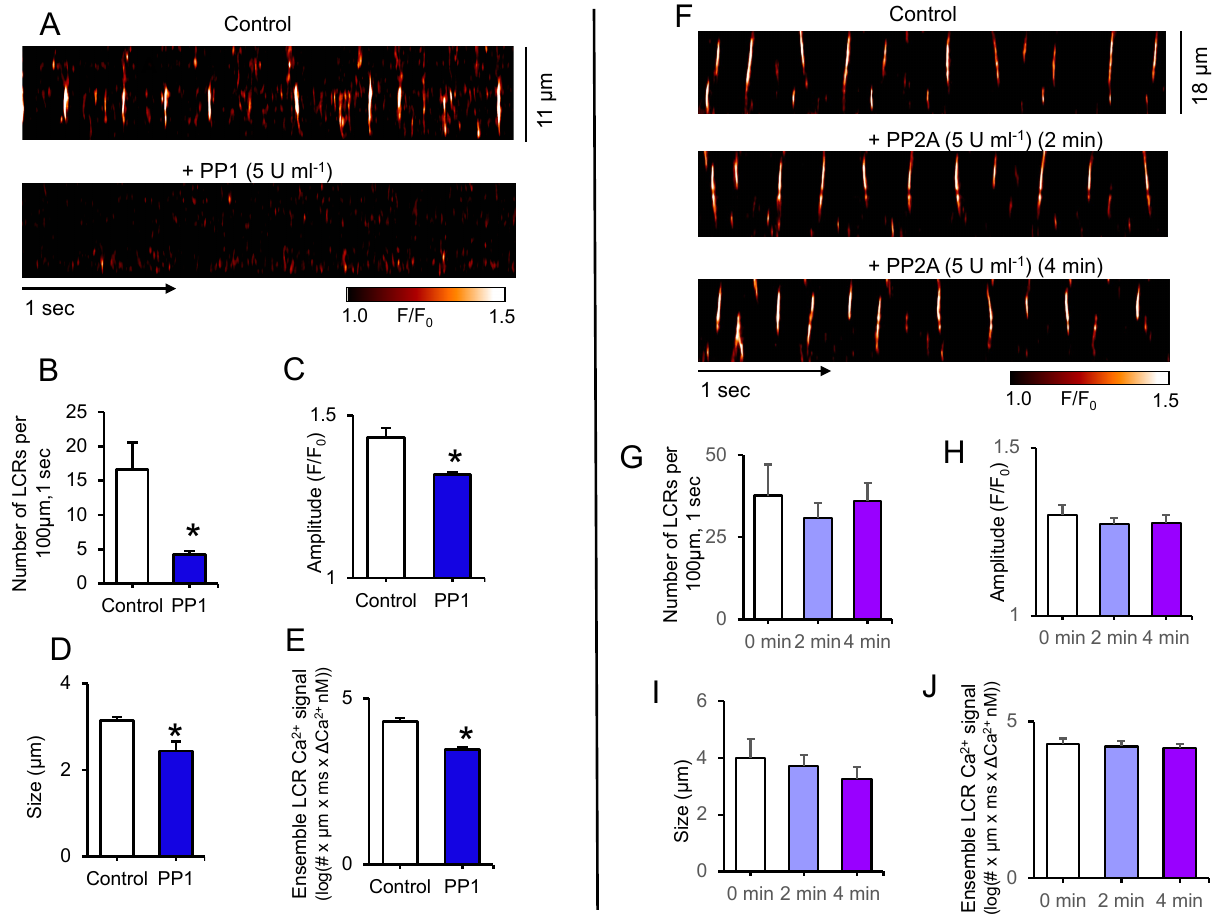
Figure 5. Representative confocal line-scan images of LCRs in permeabilized SANC bathed in 150 nmol/L [Ca 2+ ] in control conditions and during incubation with purified PP1 (5 U mL − 1 ) ( A ) or PP2A (5 U mL − 1 ) catalytic subunits ( F ). Changes in local Ca 2+ release (LCRs) characteristics before and during exposure to PP1 ( n = 4) ( B – E ) or PP2A ( n = 6) ( G – J ); ( B , G ) Number of LCR events per 100 µ m of the line-scan image and during a 1-sec time interval; ( C , H ) LCR amplitude (F/F 0 ); ( D , I ) LCR size (as FWHM, the full width at half-maximum amplitude); ( E , J ) Average ensemble of LCR Ca 2+ signals (as log of the integrated Ca 2+ signal produced by each LCR; #-represents number of LCR events). * p < 0.05, the paired t -test vs. control ( B – E ); one way ANOVA ( G – J